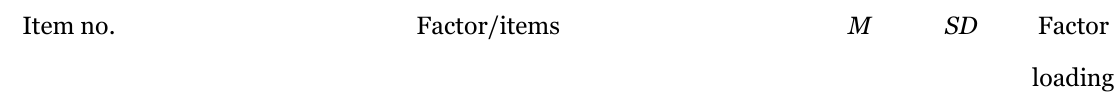
Items and Factor Loadings of Four Factors on the TRS-OCW Item